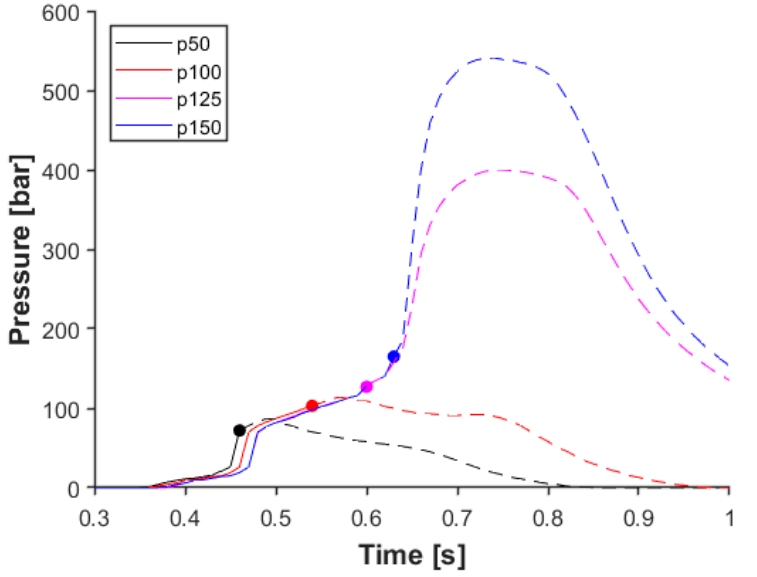
Figure 6. The effect of the switchover pressure threshold on in-mold pressure, measured with a sensor in a runner (tertiary channel sensor to cavity 02).